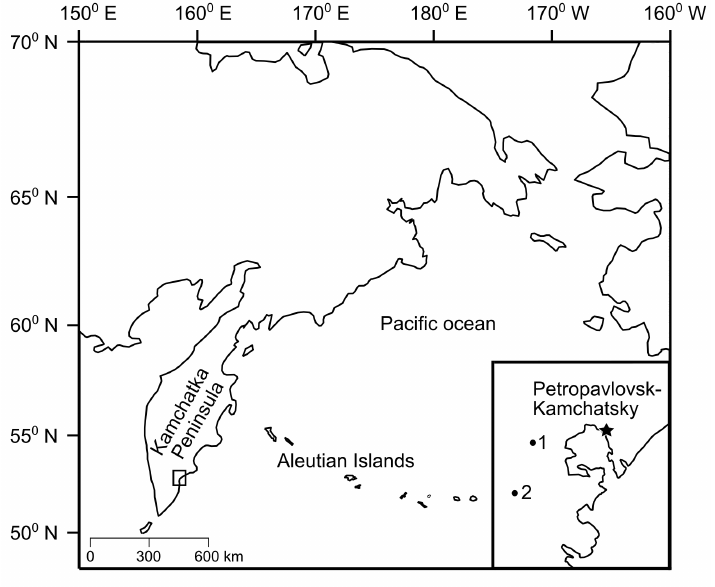
Figure 1. Location of the measurement sites “Mikizha” (1) and “Karymshina” (2) where the experiments were carried